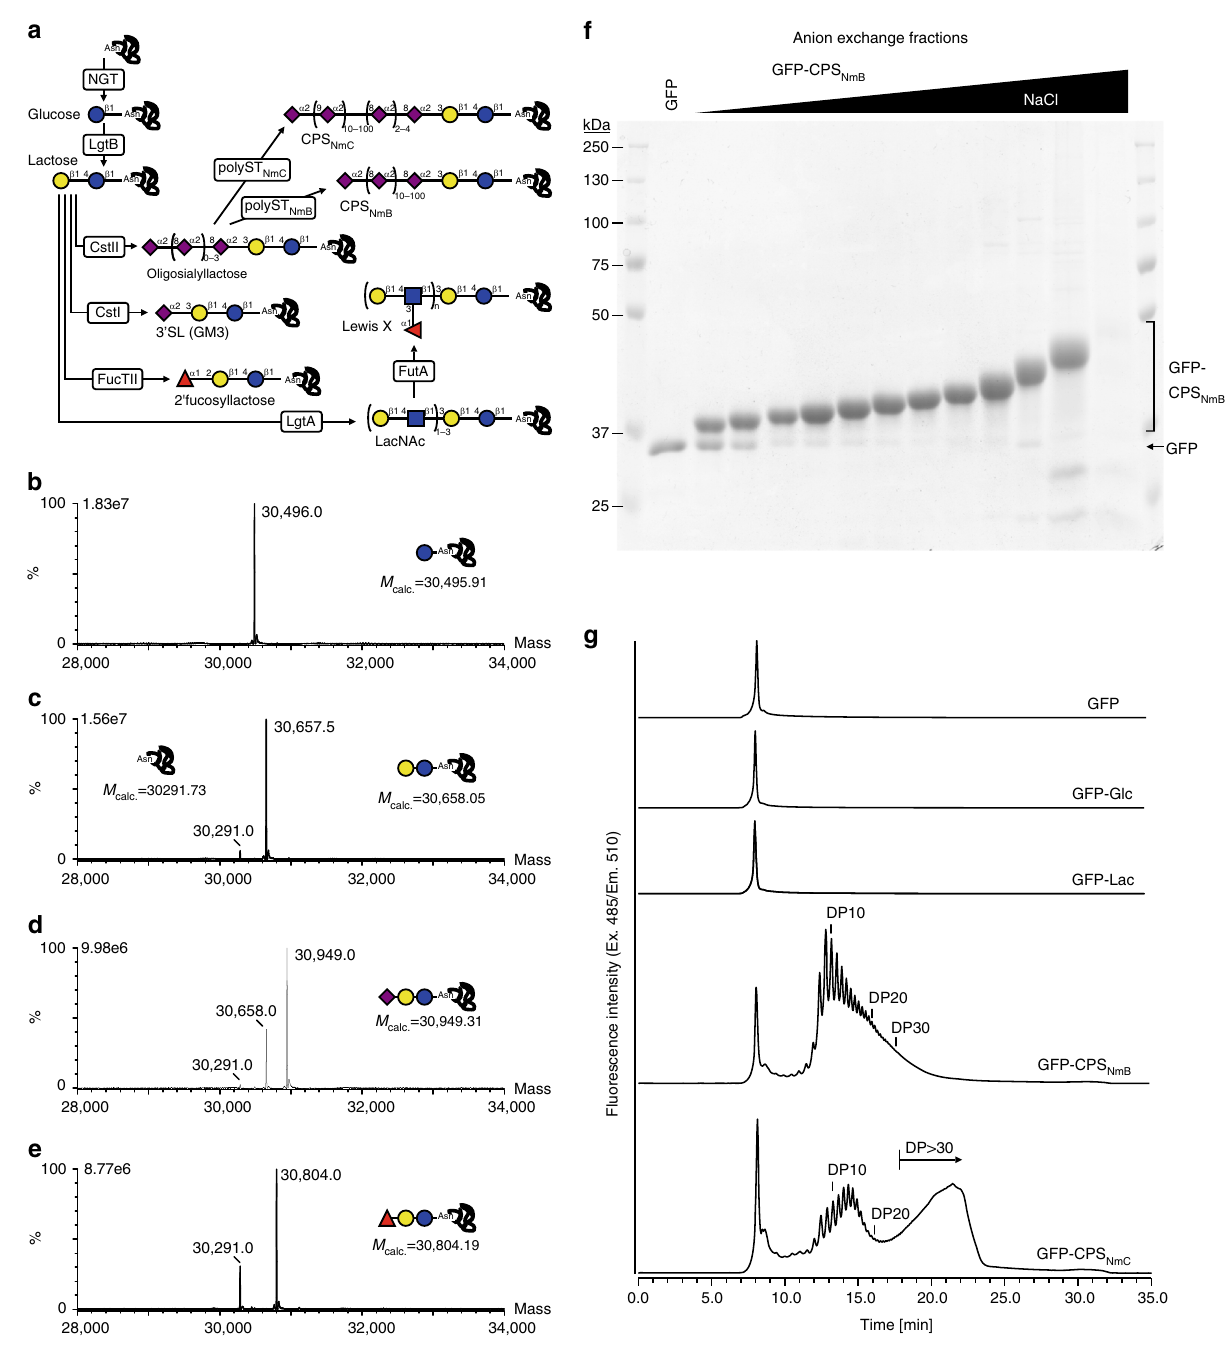
Fig. 1 Cytoplasmic protein glycosylation. a Overview of protein glycosylation pathways. The protein – glycan linkage is established by transfer of a single glucose onto an asparagine residue, in the N-x-S/T sequon (where, x ≠ P), by the N-glucosyltransferase (NGT). The N-linked glucose (N-Glc) serves as a primer for combinations of glycosyltransferases from different bacterial species to synthesize a variety of oligosaccharide or polysaccharide structures on the target protein. Following co-expression with the respective glycosylation pathway, the (glyco)protein products were puri fi ed and analyzed by MS, SDS- PAGE, or analytical anion exchange chromatography. Mass spectra of intact proteins modi fi ed with b glucose, c lactose, d 3 ′ -sialyllactose (3 ′ SL), and e 2 ′ - fucosyllactose. f Coomassie-stained SDS – PAGE of fractions from preparative anion exchange chromatography of GFP modi fi ed with CPS NmB . g Puri fi ed, polysialylated GFP fractions modi fi ed with CPS NmB and CPS NmC were analyzed by anion exchange chromatography. The number of sialic acids in the polysaccharide are indicted as degree of polymerization (DP). Sugar symbols are drawn according to the guidelines of the Consortium for Functional Glycomics. Blue and yellow circles represent glucose and galactose, respectively. Red triangles and purple diamonds indicate fucose and sialic acid, respectively. Source data are provided as a Source Data fi